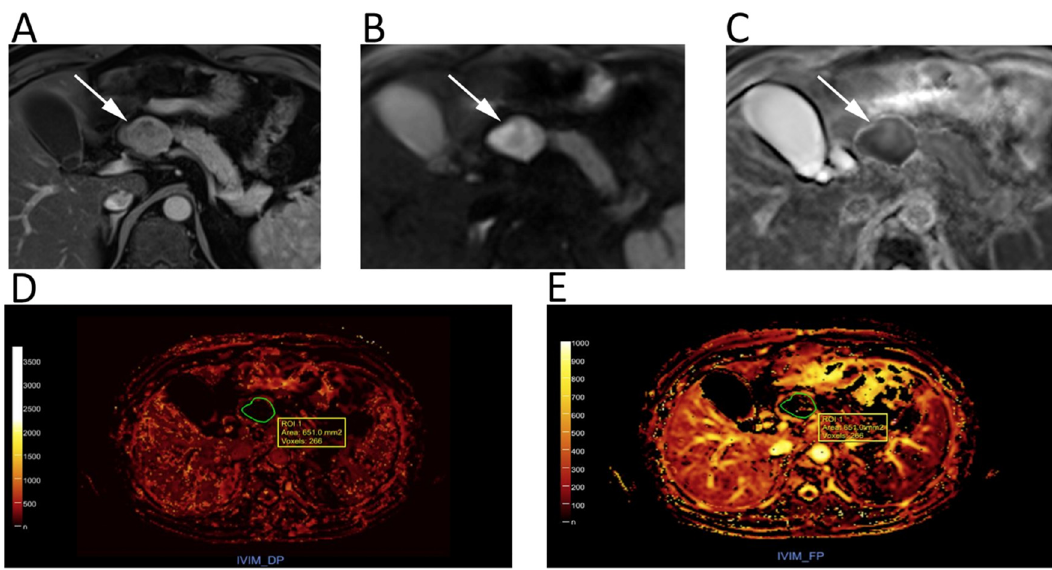
Figure 6. Upper abdomen MRI of a patient with G2 pancreatic neuroendocrine neoplasm. A heterogeneous hypervascular lesion (arrows) with well-defined margins can be seen on the axial arterial phase image ( A ). The lesion is clearly hyperintense on b = 800 DWI ( B ), with low ADC values on the corresponding ADC map ( C ). IVIM maps show that the tumor has low values of fast diffusion (Dp, D ) but relatively preserved perfusion fraction (f, E ), consistent with a neuroendocrine neoplasm. Prognosis in patients with pancreatic tumors is highly influenced by tumor stage and grade.